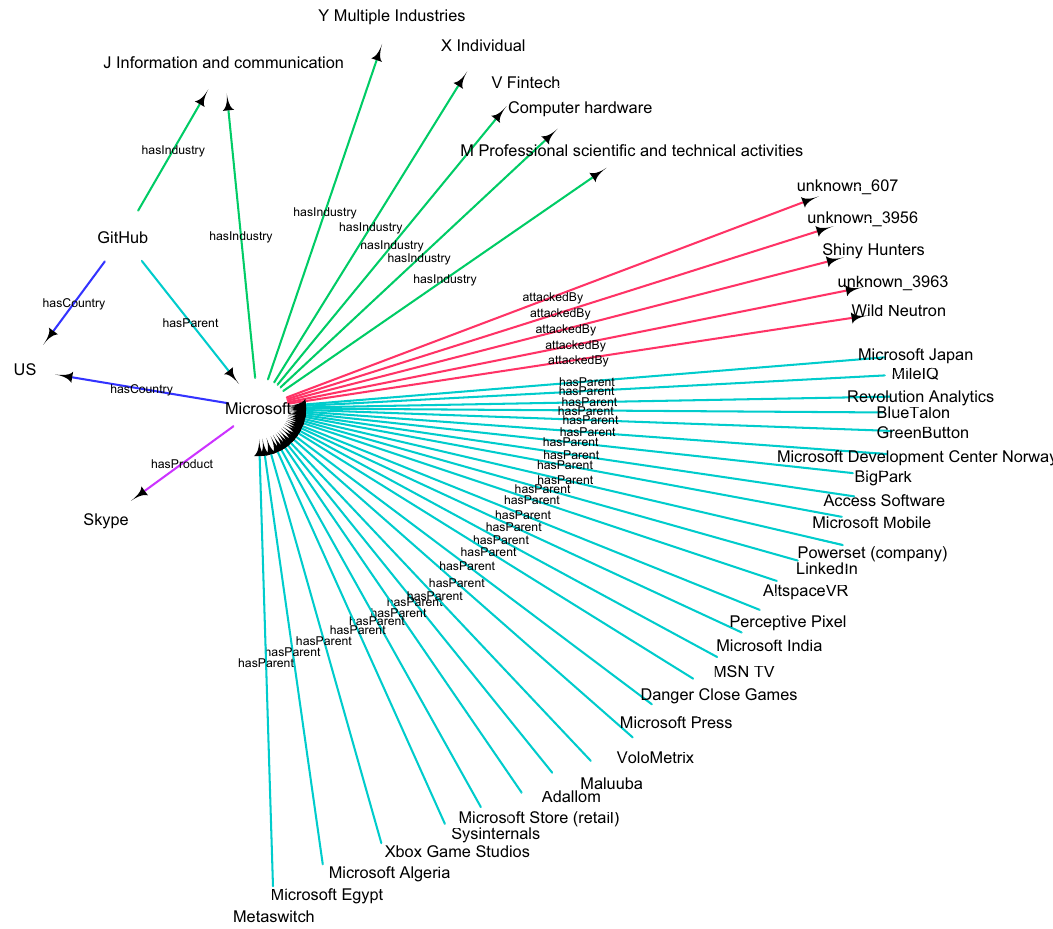
Figure 7. An example subset of the knowledge graph showing an egocentric network of the company Microsoft. The central entity is connected to the reported malicious entities (red links), the industries reported in the dataset as well as the ones obtained from DBpedia (green links), country (blue link), products (purple links) and child companies (turquoise links). The network is a subset of the knowledge graph with nodes and links of a single step from the focal node. The central nodes of this subset are connected to the focal node by green and blue links.